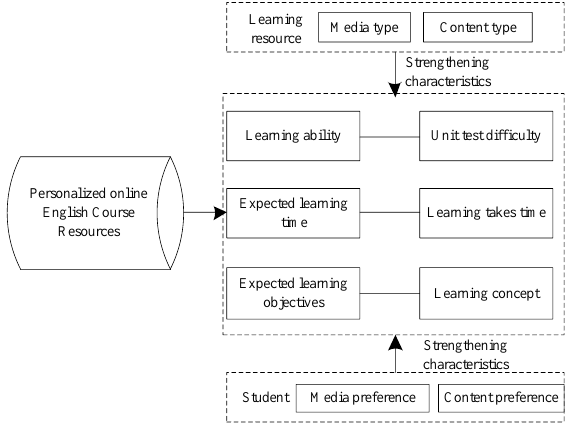
Figure 6. Unit test recommendation model